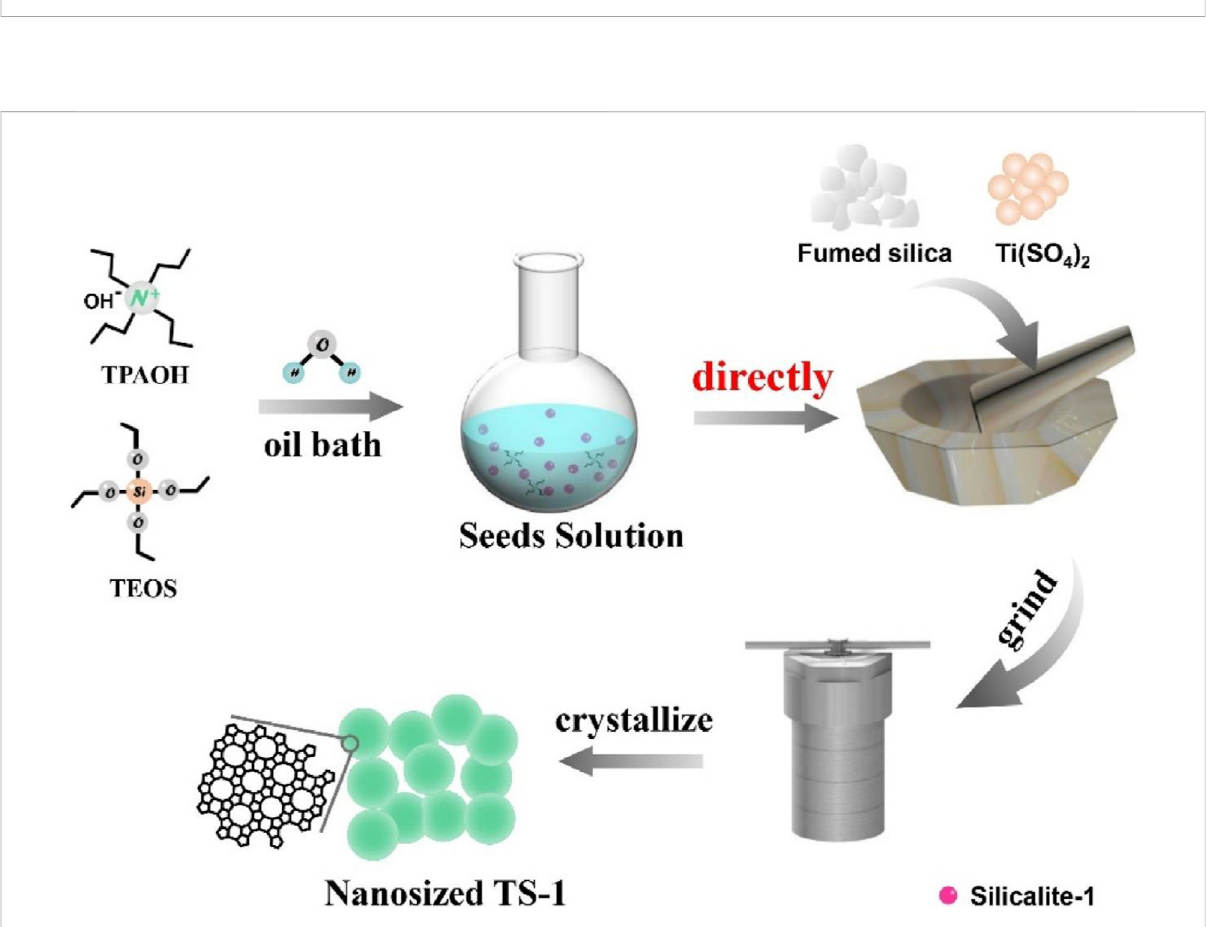
FIGURE 5 The schematic process of synthesizing anatase-free nanosized TS-1 zeolite under solvent-free conditions. Reprinted with permission from Liu et al. (2022). Copyright 2021 Elsevier.